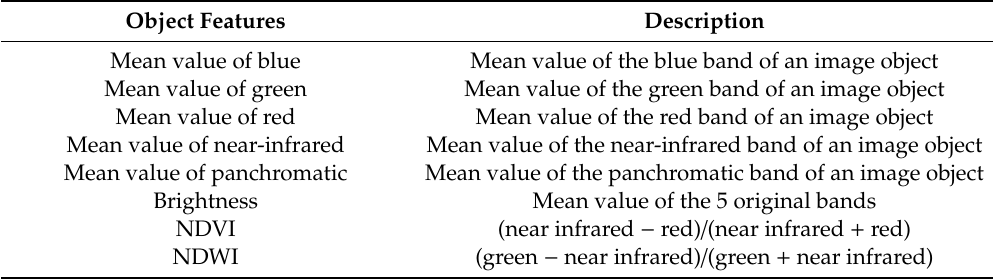
Table 2. Object features used for supervised